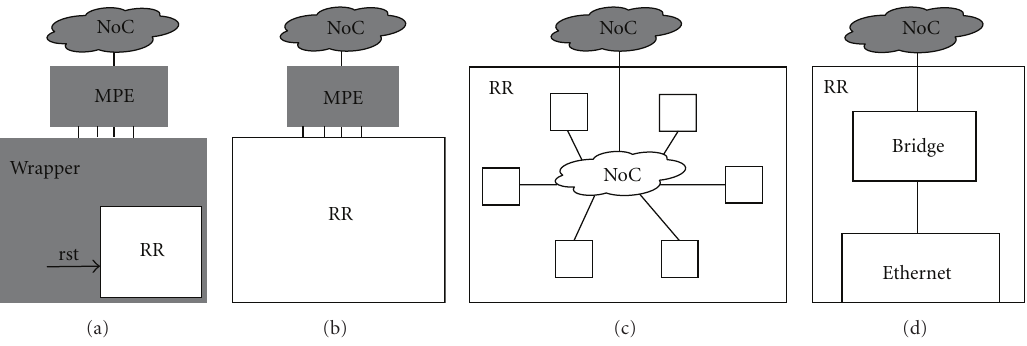
Figure 3: (a) Wrapper-contained RR, (b) Self-contained RR, (c) and (d) no-MPE RRs. (Gray means static and white means dynamic).